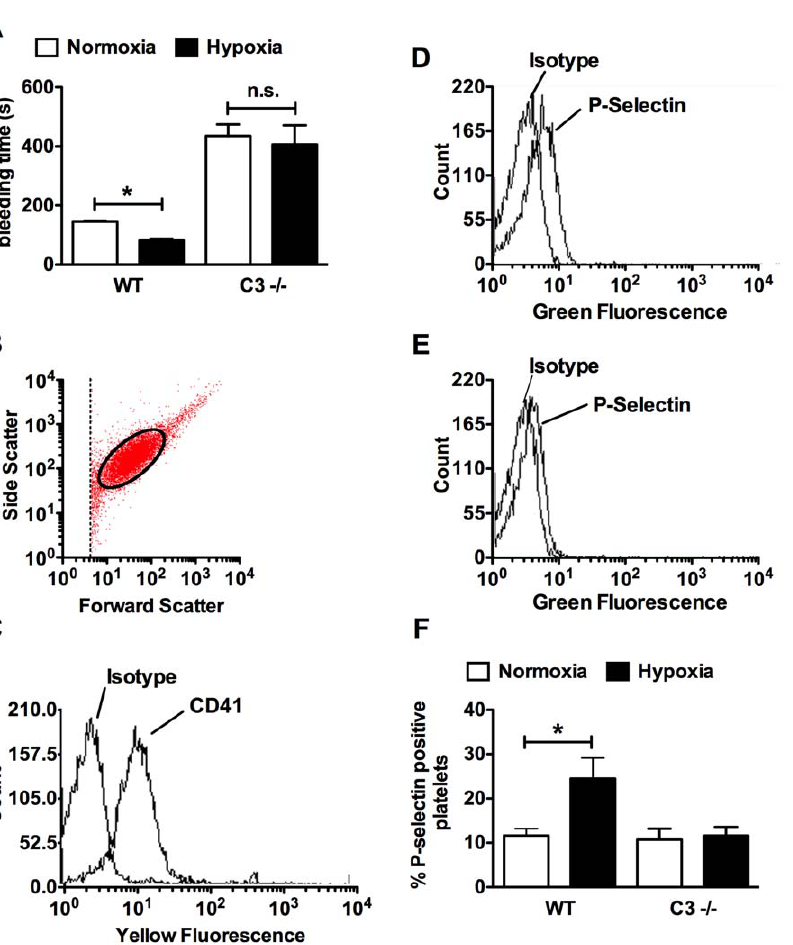
Figure 8. Loss of C3 prevents platelet activation caused by CH. (A) Bleeding time of WT and C3 2 / 2 mice exposed to normoxia or CH (n=5– 7). (B) Scatter plot showing platelet population in platelet rich plasma. All experiments were similarly gated to the area encircled. (C) Flow cytometry histogram demonstrating that the gated cell population is positive for the platelet marker CD41. (D–E) Representative flow cytometry histograms of platelets from (D) hypoxic WT or (E) hypoxic C3 2 / 2 mice stained with P-selectin antibody or isotype control. (F) Percent P-selectin positive platelets in PRP isolated from normoxic and hypoxic WT or C3 2 / 2 mice (n=6). Bars represent mean 6 SD. * P , 0.05; n.s.=not significant.